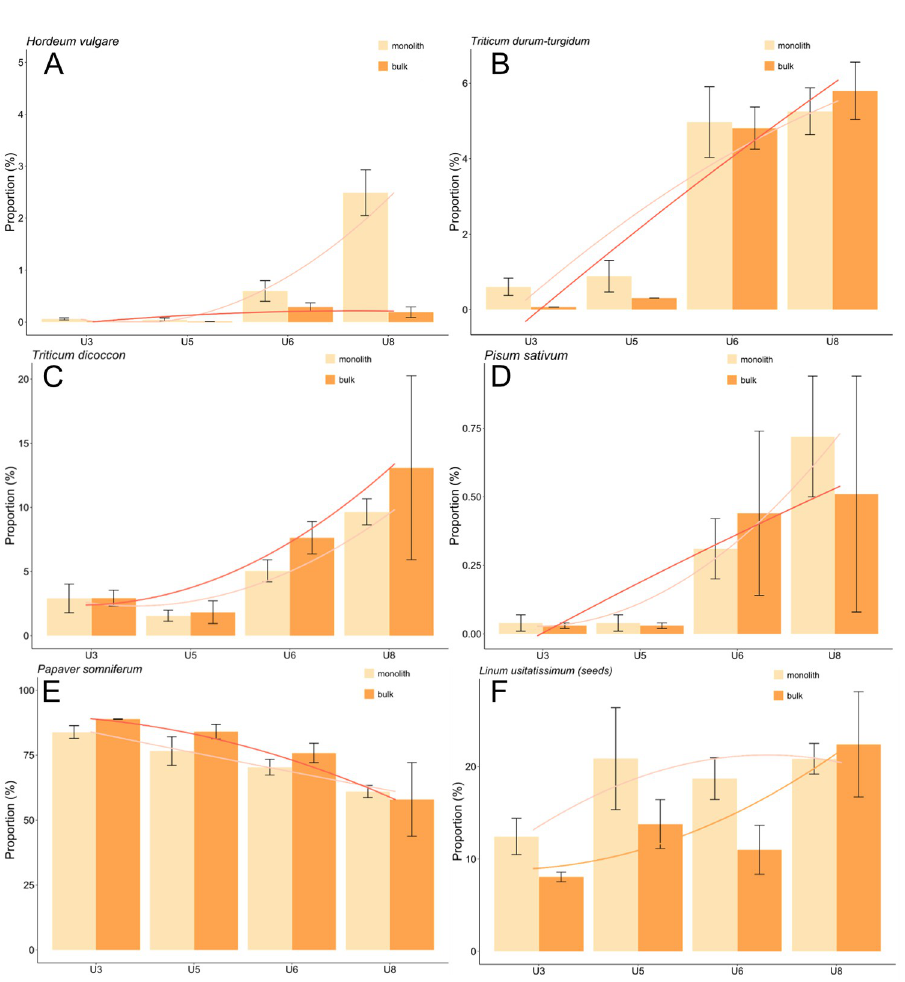
Fig 11. A-F Proportions of waterlogged selected crop plants (mean ± standard error).